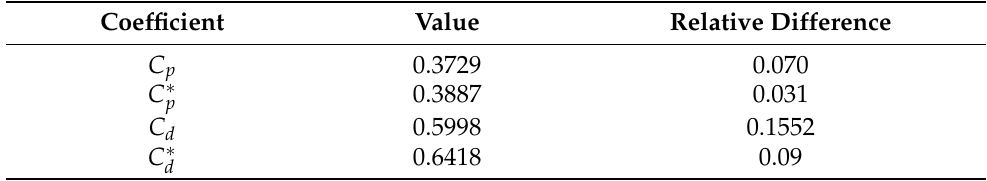
Table 7. Coefficient values with their relative differences with the experiment